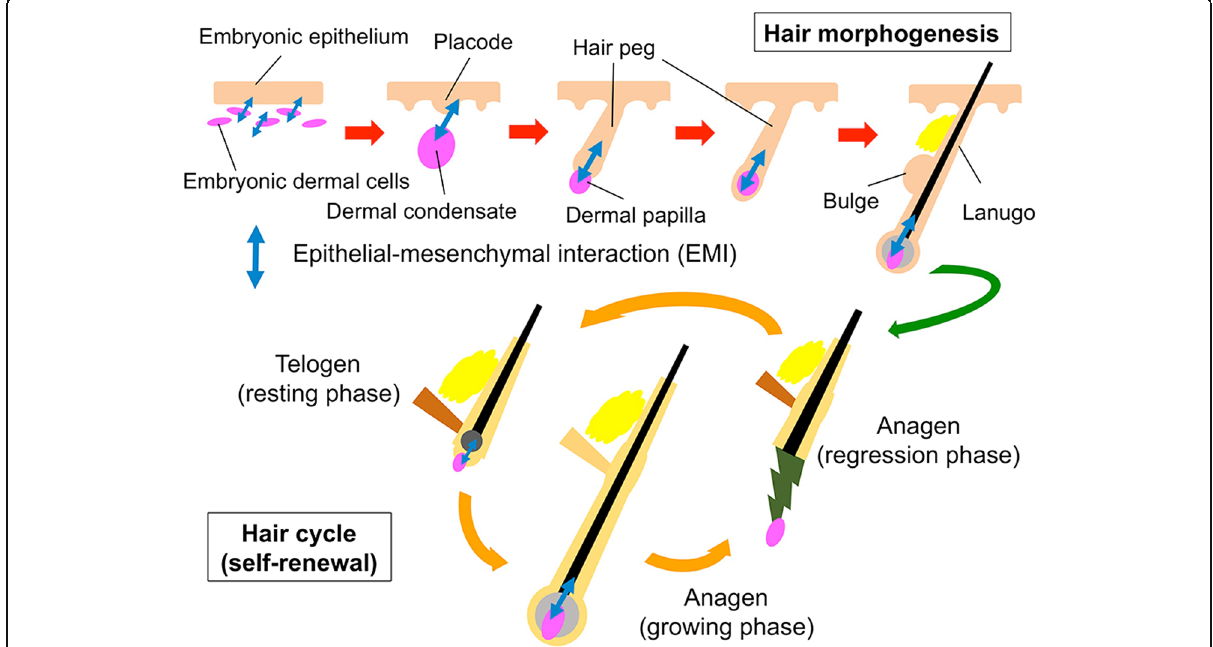
Fig. 2 Hair follicle morphogenesis and hair cycle Hair follicle morphogenesis and hair cycle are enabled by well-orchestrated epithelial- mesenchymal interactions. In morphogenesis, crosstalk between the placode and the dermal condensate (the precursor of the dermal papilla) initiates epithelial invagination to form the lanugo. In hair cycle, communication between bulge stem cells and the dermal papilla is thought to play key roles in telogen (resting phase)-anagen (growing phase)